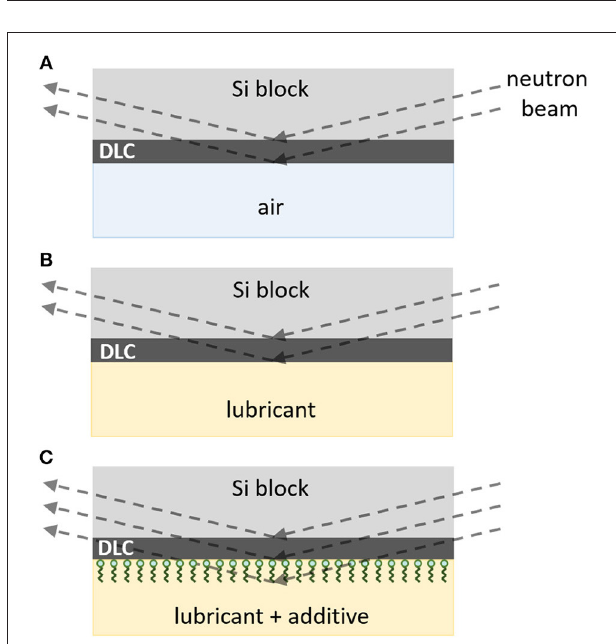
FIGURE 3 | Experimental procedure used to measure the adsorption of additive molecules to the DLC coating with the highest accuracy: (A) first, reflectivity profile for air/DLC interface is measured, (B) then the reflectivity profile of the coating is checked in the presence of the base liquid, and (C) the base liquid is replaced by an additive solution. The last step can be repeated to monitor either the influence of the exposure time on the adsorption in static experiments or the influence of rubbing on the film growth/removal in dynamic